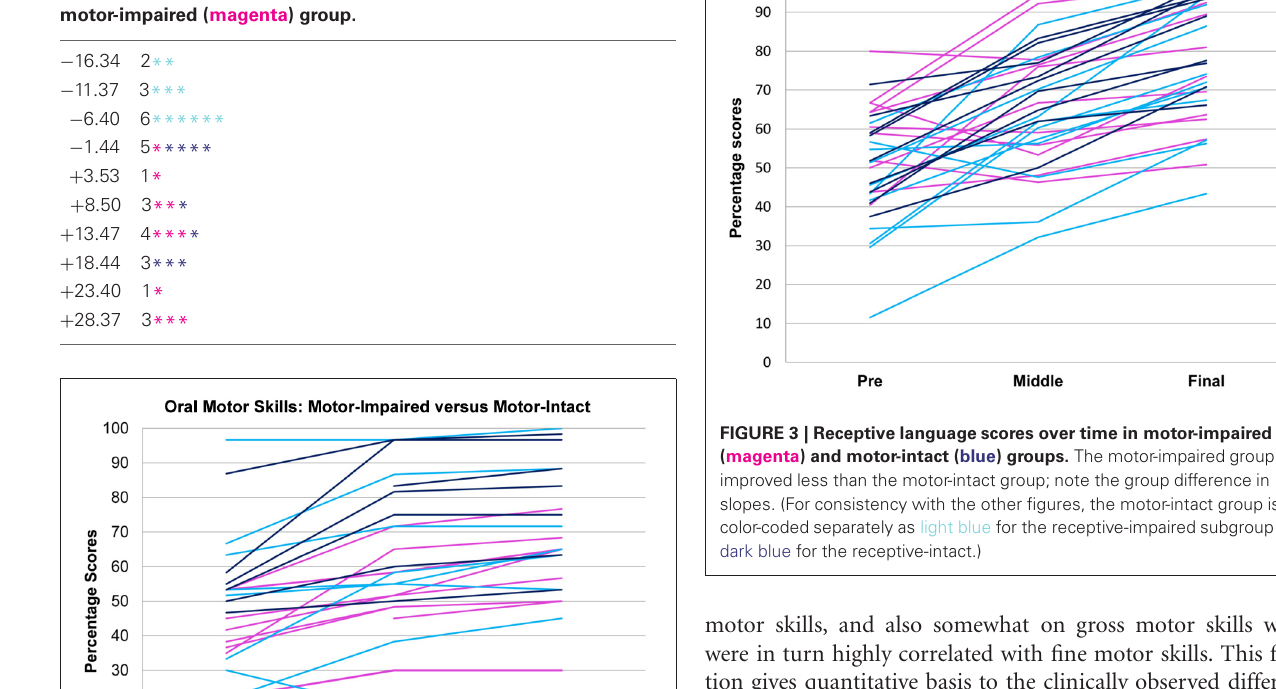
Table 3 | Histogram of values of the receptive-expressive language difference (RL-EL) for the motor-intact receptive-impaired (light blue) and motor-intact receptive-intact (dark blue) subgroups, and the motor-impaired (magenta) group.